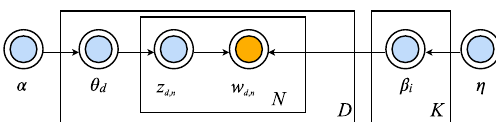
Fig. 11 Architecture of graphical model for